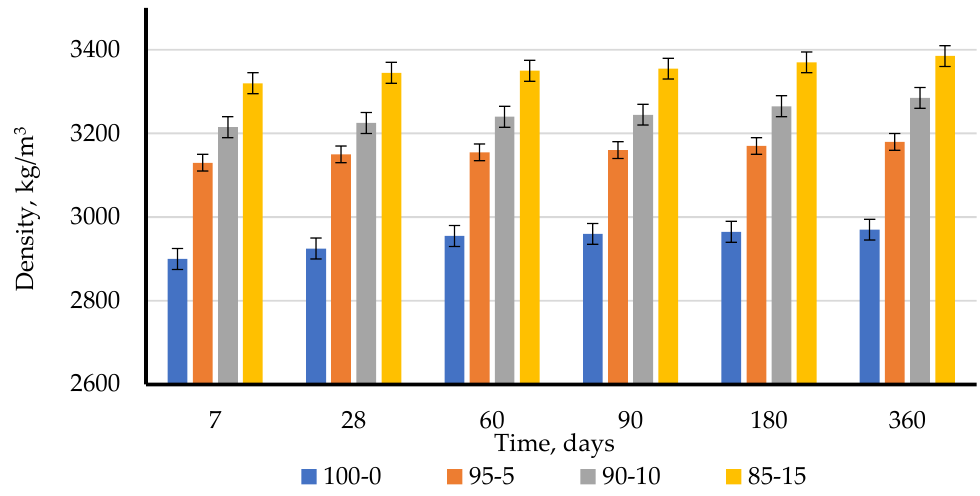
Figure 8. Density of the mixed cement samples at different periods of hardening. Table 5. Results of the strength tests of the cement samples at different periods of hardening (days).